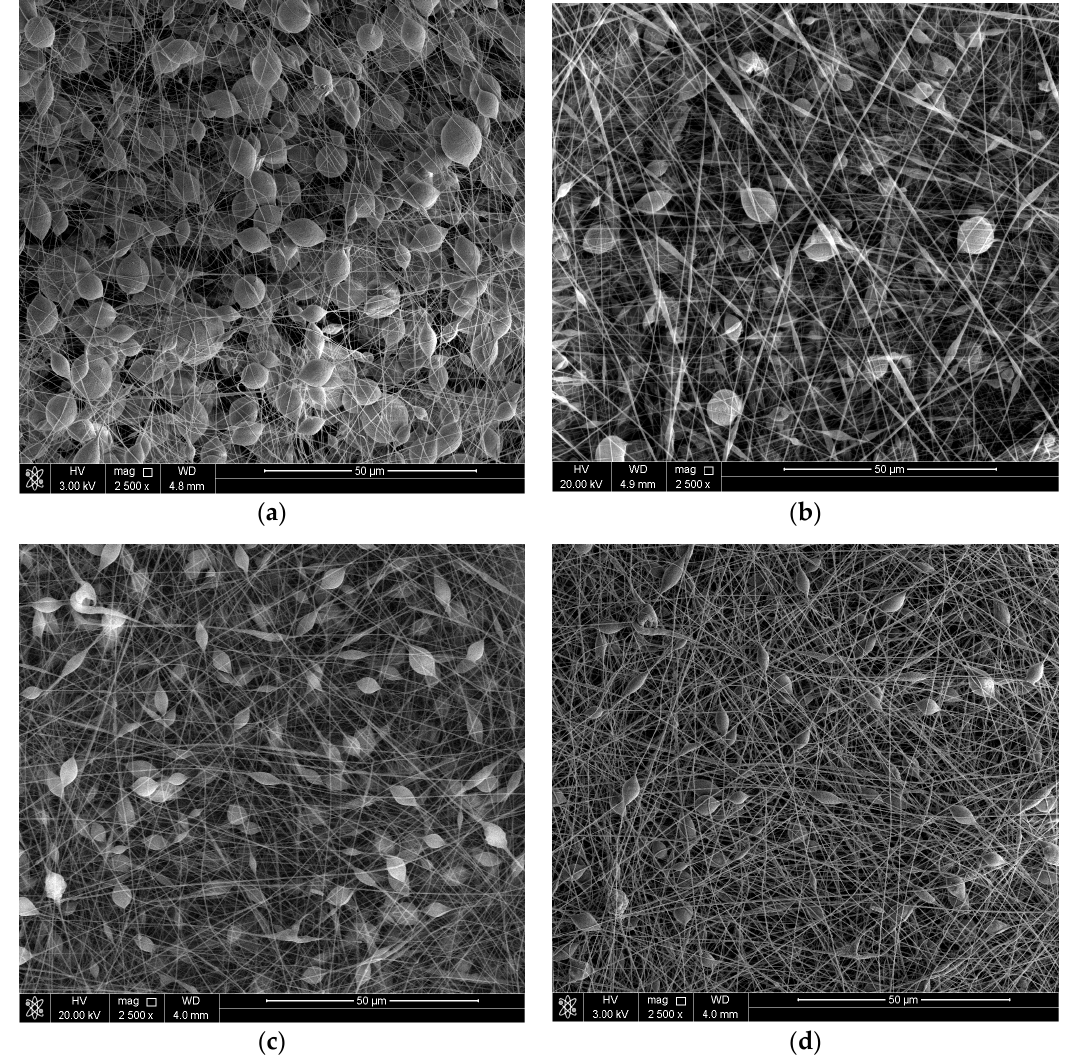
Figure 2. The SEM images of PS/Al 2 O 3 nanocomposite coating for ( a ) PA1, ( b ) PA2, ( c ) PA3, and ( d ) PA4 (See Table 1 for Operational parameters). Table 2. The average diameter of the nanofibers and beads of ( a ) PS and ( b ) PS/Al 2 O 3 nanocomposite coatings. ( a )